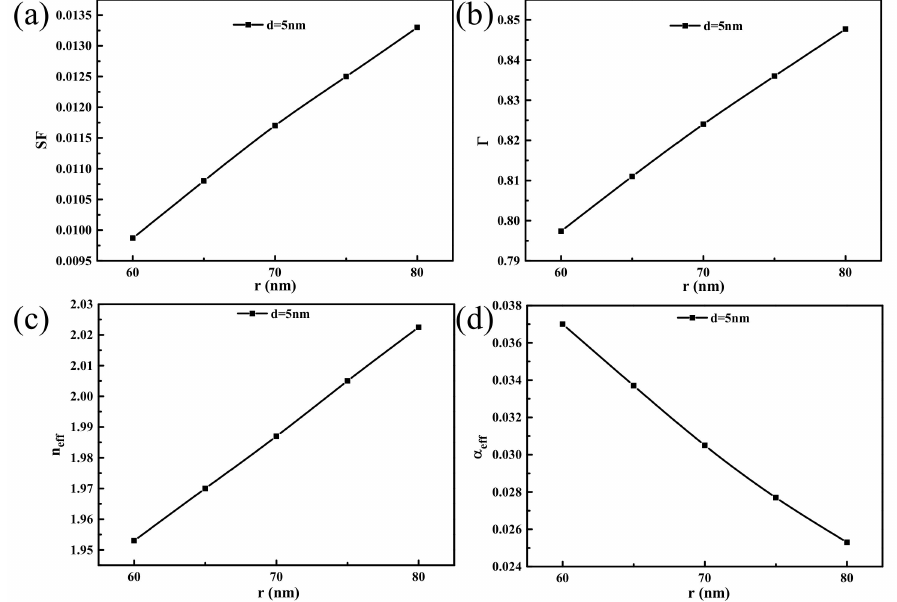
Figure 6. When dielectric layer thickness d = 5 nm, the mode properties change with the nanowire radius r . ( a ) The normalized model area SF, ( b ) the confinement factor Γ , ( c ) the effective index n eff and ( d ) the effective propagation loss α eff